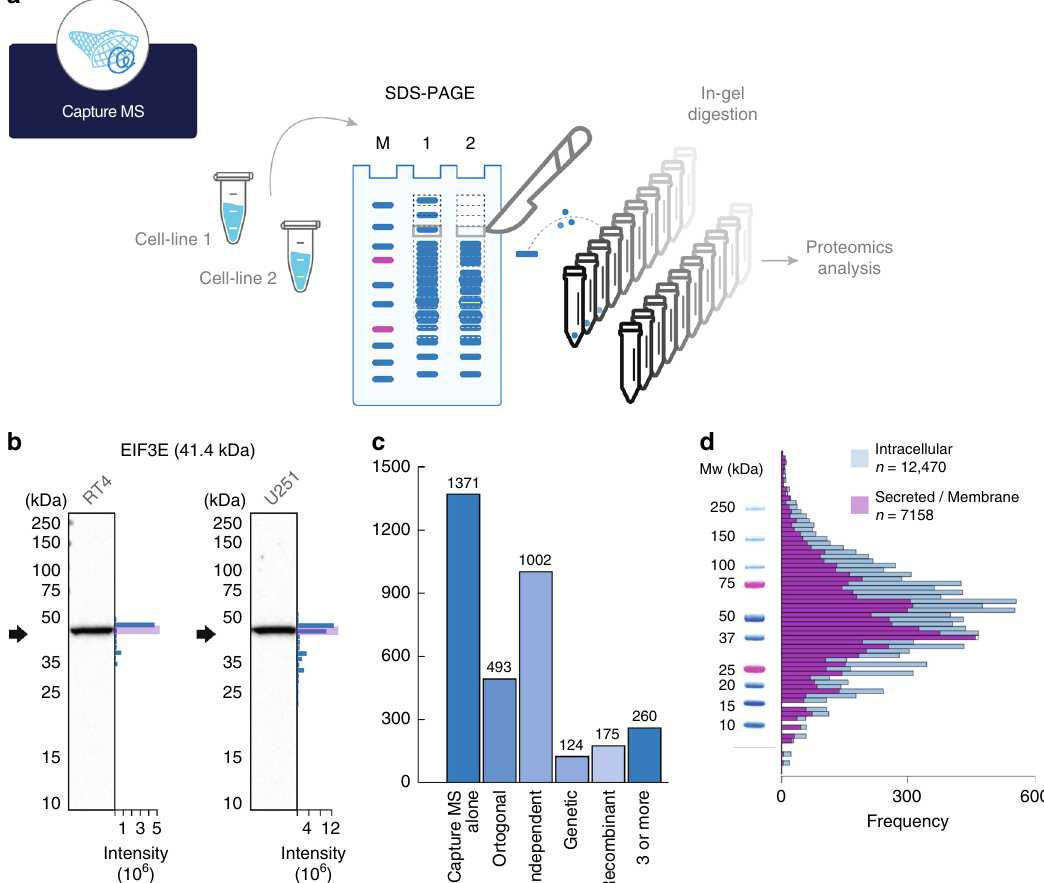
Fig. 3 Validation of antibodies using capture MS. a Principle for validation of antibodies based on separation by SDS-PAGE and comparing the protein migration pro fi le determined by an antibody (Western blot) and peptide identi fi cation performed by proteomics (capture MS). b Examples of orthogonal validation of two antibodies by capture MS in two different cell lines (RT4, U-251). The black arrow indicates theoretical molecular weight, and the blue bars represent number of peptides identi fi ed in each gel slice. c Summary of capture MS validation of antibodies ( n = 2,888) showing if they were validated using other antibody validation pillars. d Distribution of theoretical molecular weights for the largest transcript of all ( n = 19,628) human protein-coding genes divided into intracellular (blue) and secreted and membrane bound proteins (purple). Molecular weights are represented by the log 2 value together with a molecular weight ladder from a typical Western blot assay used within the Human Protein Atlas